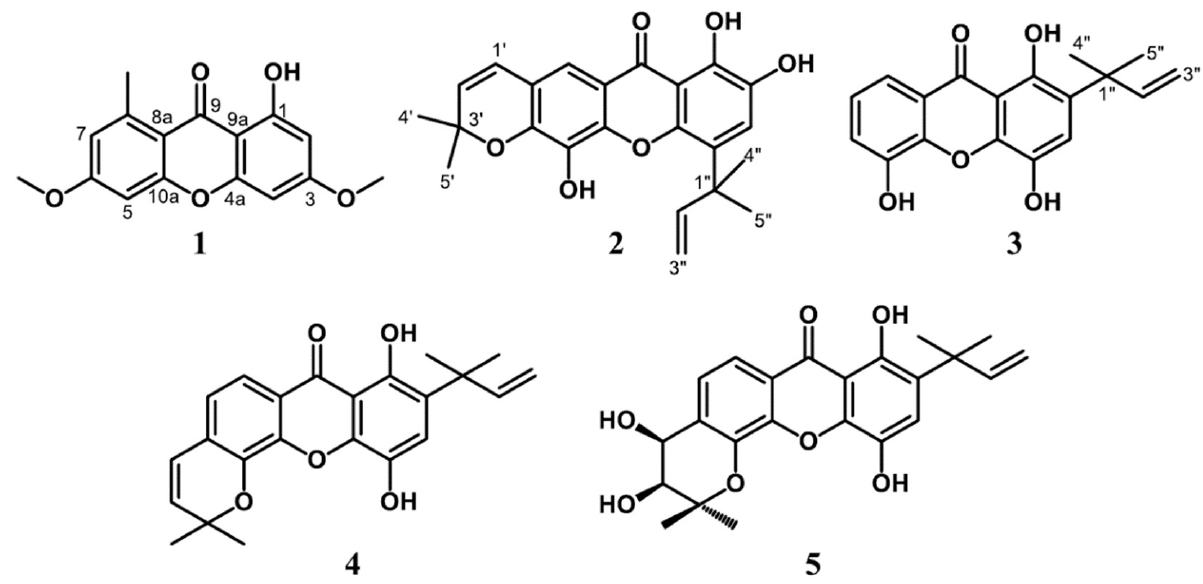
Figure 1. The isolated compounds ( 1 – 5 ) from the stem barks of G. forbesii.